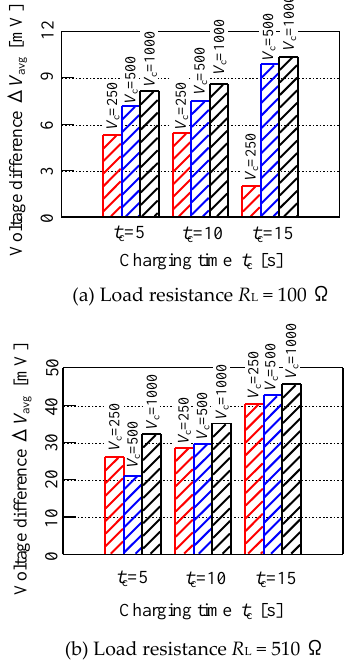
Figure 11. Bar graph of voltage difference for different sensor condition.